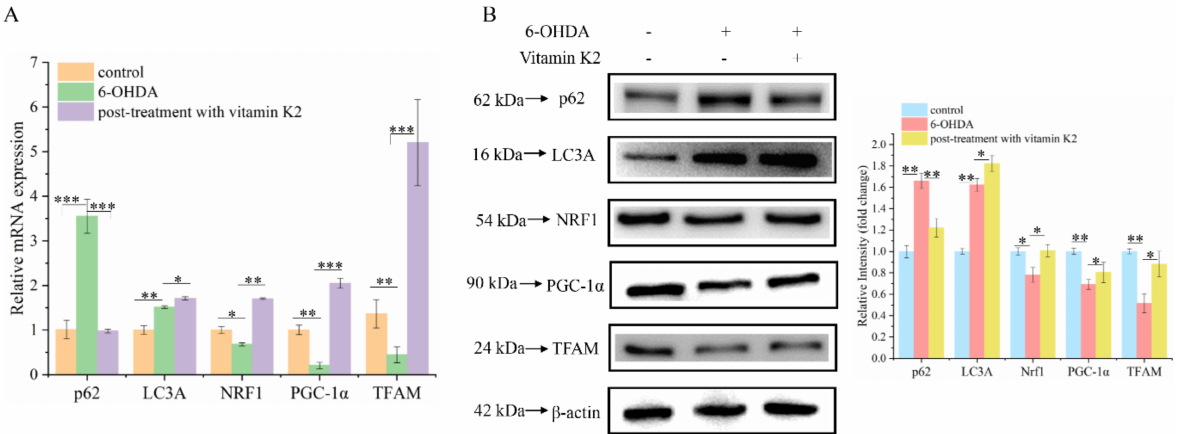
Figure 6. Effects of vitamin K2 on mitophagy and mitochondrial biogenesis in 6-OHDA-injured cells. ( A ) Measurement of p62, LC3A, PGC-1 α , NRF1, and TFAM mRNA expression changes by RT-qPCR. ( B ) Changes in protein expression levels of p62, LC3A, PGC-1 α , NRF1, and TFAM assessed by Western blot; images were quantified by using the ImageJ software. The data are presented as mean ± SD ( n = 3). Significant difference * p < 0.5, ** p < 0.05, and *** p < 0.01 vs.